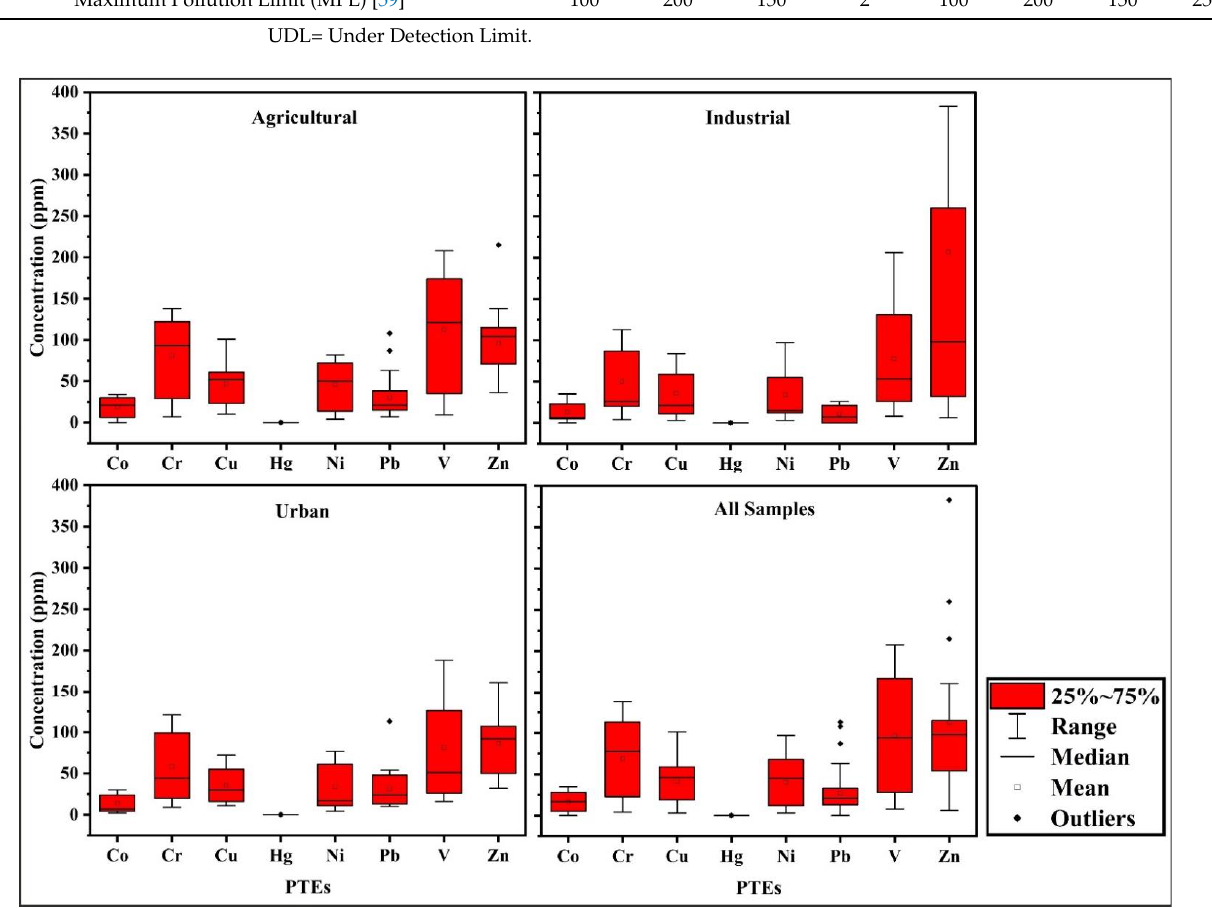
Figure 3. Boxplots of PTE concentrations in different land-use soil. Comparing the obtained results with the world soil average [65] (Table 1), Co, Cr, Cu, Ni, Pb, V, and Zn concentrations surpassed this average in 56.8%, 56.8%, 50.9%, 56.8%, 25.5%, 35.3%, and 64.7% of the considered samples, respectively. This indicates that the PTE distribution may be adversely affected by anthropogenic activities in varying degrees. Comparing with the threshold values for soil quality [66] (Table 1), Co, Cr, Cu, Ni, Pb, V, and Zn indicated elevated levels above these values in 45.1%, 29.4%, 2.0%, 43.1%, 7.8%, 49.0%, and 7.8% of the considered samples, respectively. This indicates a potential contamination risk relating to soil quality and demands urgent consideration in future in this area. Concerning MPL in agricultural soil [66] (Table 1), all values collected in this study for the measured PTEs were less than the MPL, except for V and Zn, which surpassed that level in 27.5% and 5.8% of the considered samples,